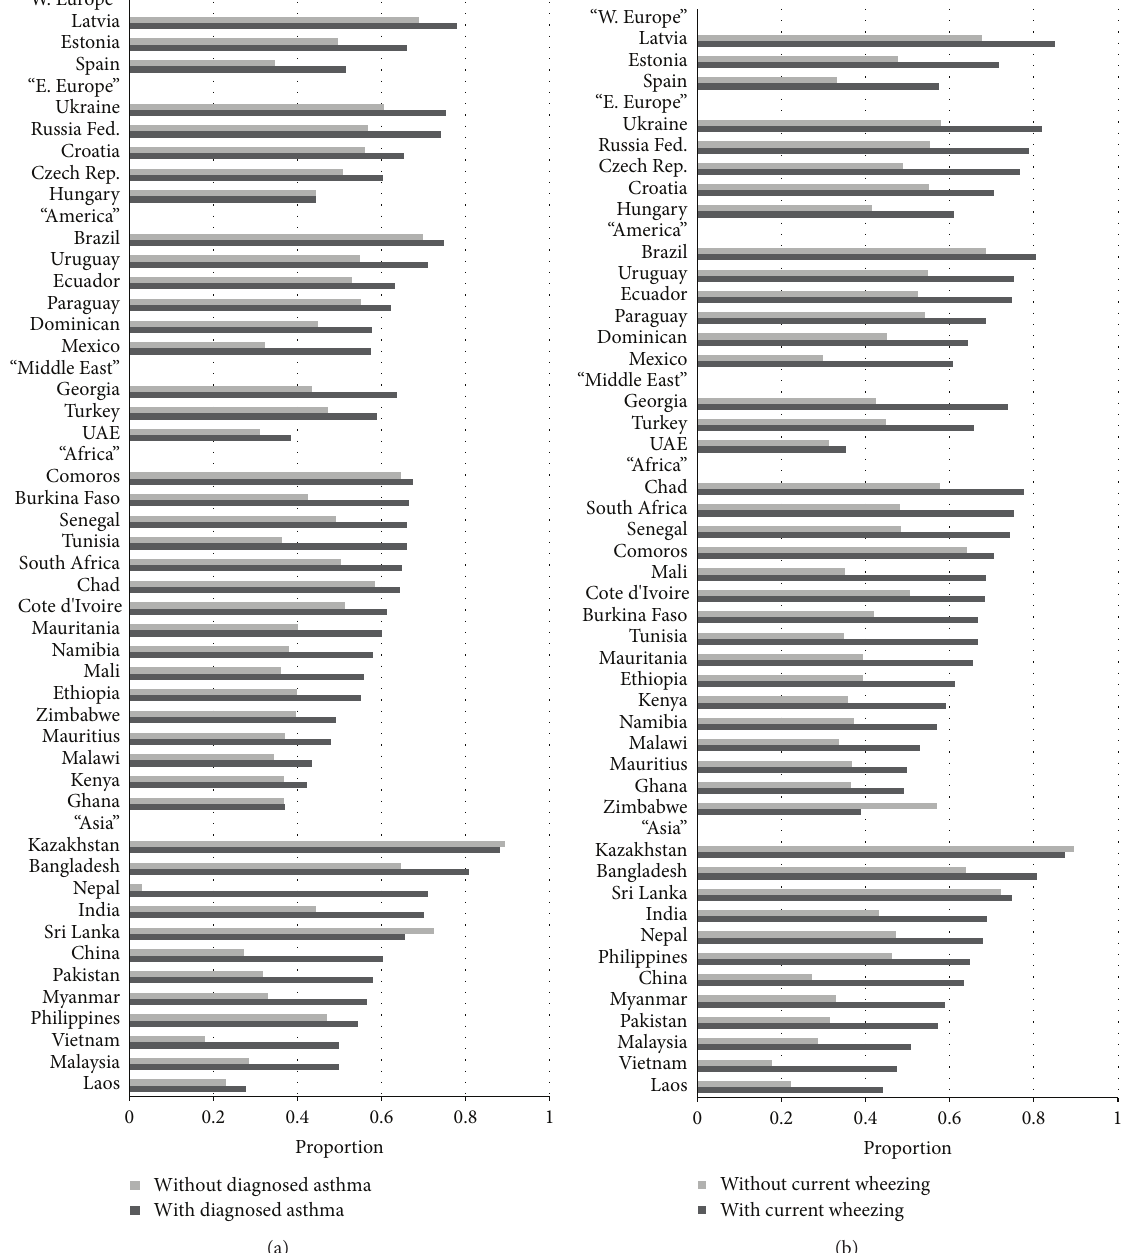
including current chest tightness and current shortness of breath also showed a general pattern of strong and consistent association with diagnosed depression and 30-day